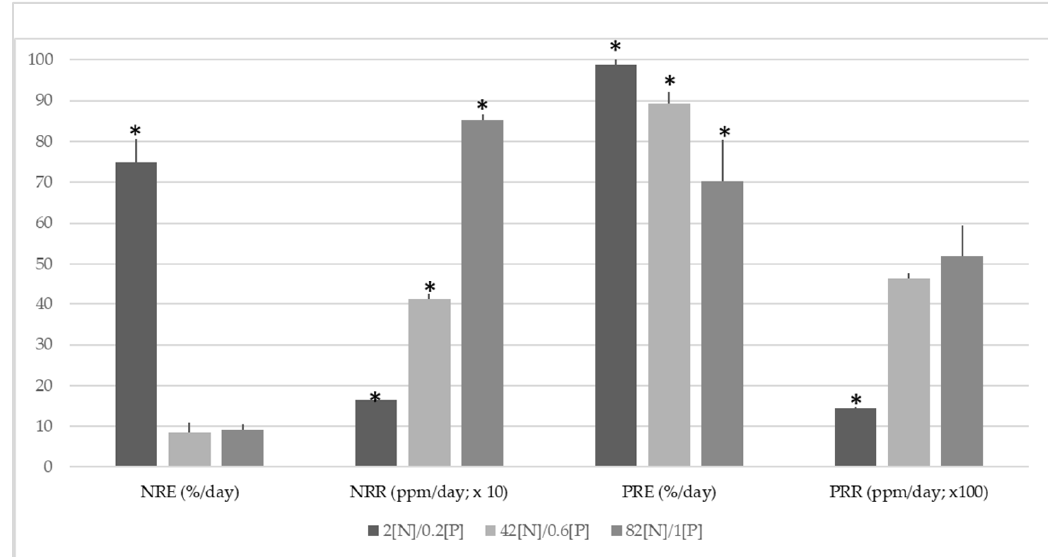
Figure 10. Bio filtration efficiency (RE) and removal rate (RR) of N and P at the different levels of these elements. Statistical significant differences ( p < 0.05) are shown by asterisks (*).